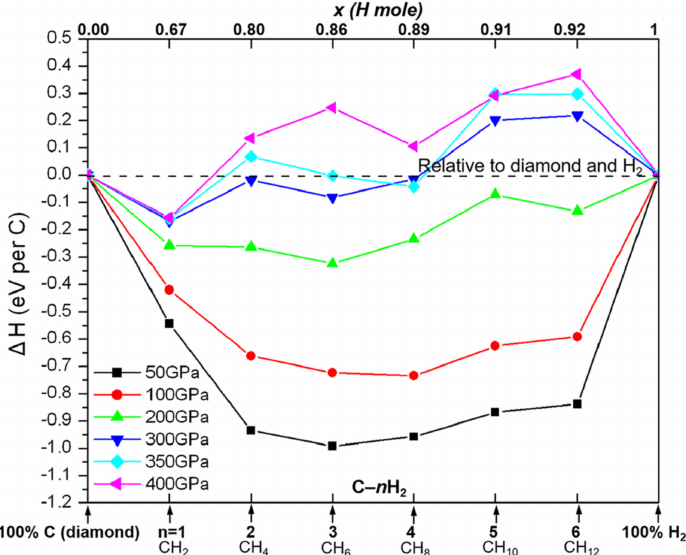
Figure 1. Relative ground state enthalpies (with respect to carbon and H 2 ) of the most stable CH n (n = 1, 2, 4, 6, 8, 10, and 12) solids. The abscissa x is the fraction of H in the structures: the mole fraction of H on top; the stoichiometry of CH n on